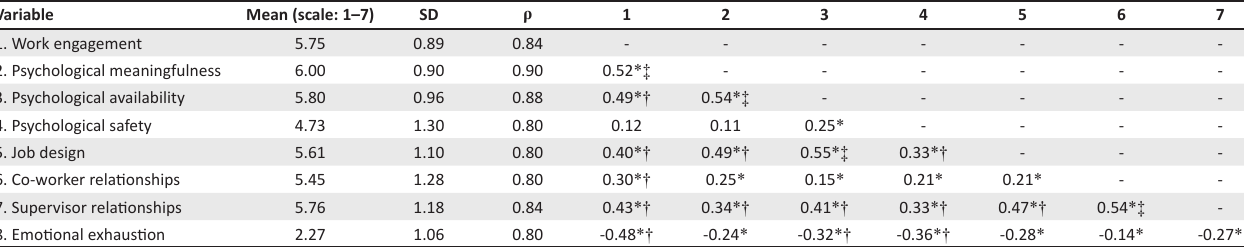
TABLE 2: Descriptive statistics, reliability (ρ) and correlation matrix of the latent variables. Variable